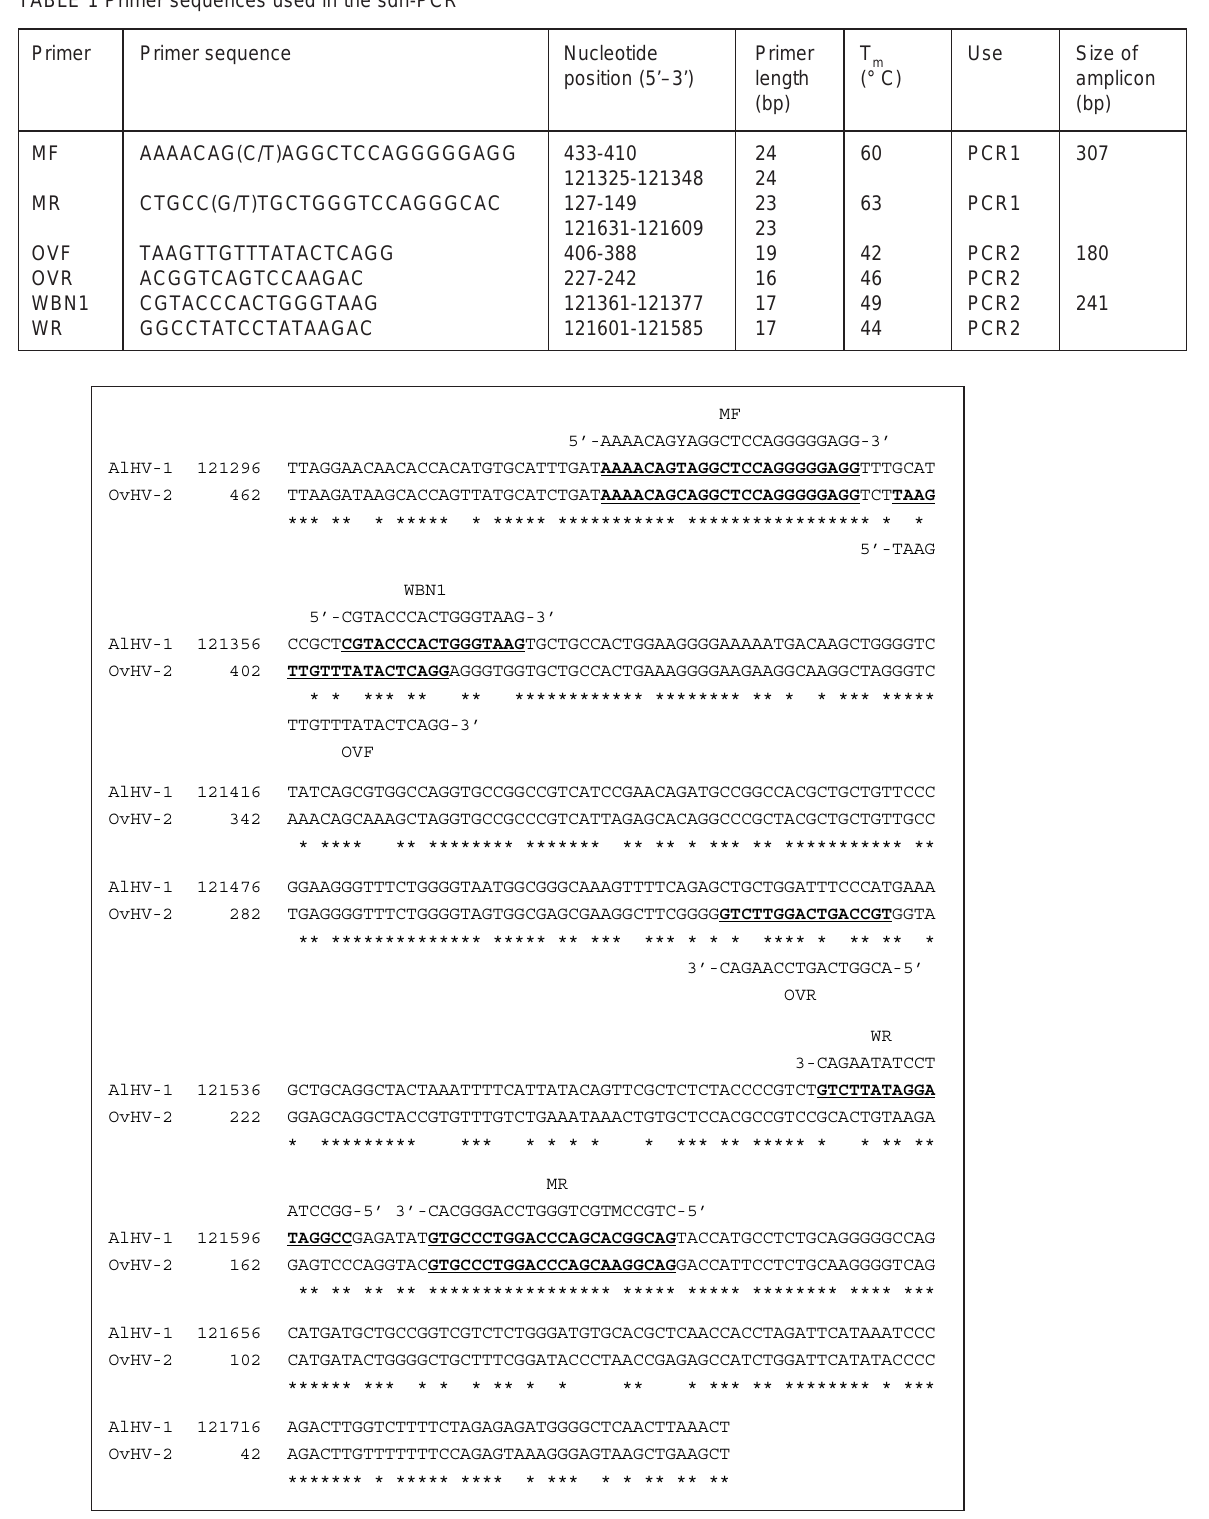
FIG. 1 Sequence alignment of a region of the tegument gene of OvHV-2 (Genbank S64565) and AlHV-1 (Genbank AF005370). Underlined regions of the sequence indicate regions selected for primer design of MF and MR (group-specific gene); OVF and OVR (for specific detection of the OvHV-1 gene) and WBN-1 and WR (for the specific detection of the OvHV-1 gene). Identical positions are indicated by